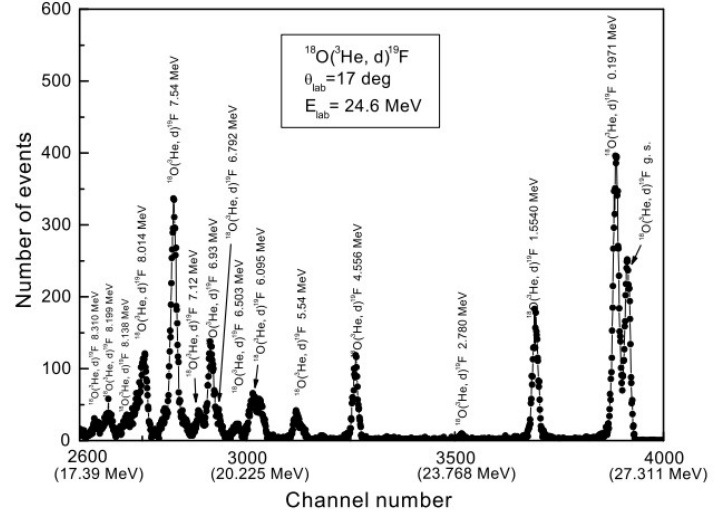
Figure 5. Part of the spectrum of deuterons from the reaction 18 O( 3 He,d) 19 F at θ lab = 17 ◦ as reported in [56].